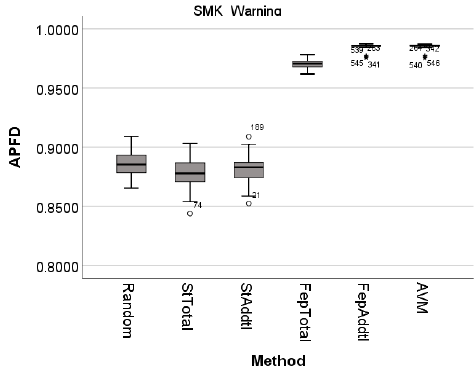
Figure 6. Test case prioritization for the PEPS